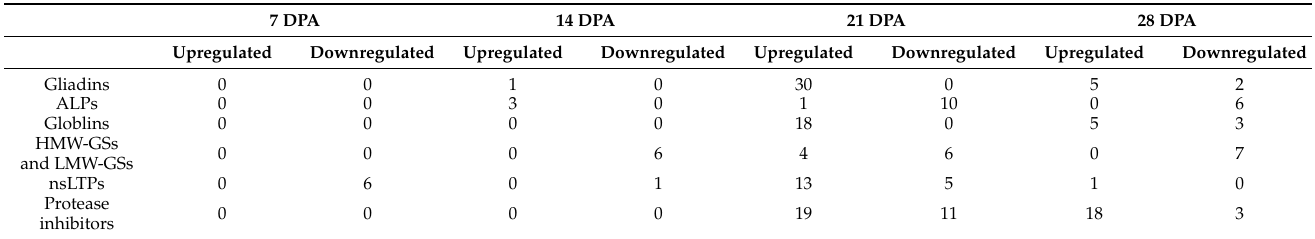
Table 3. Expression trends of different types of SSPs at different stages.